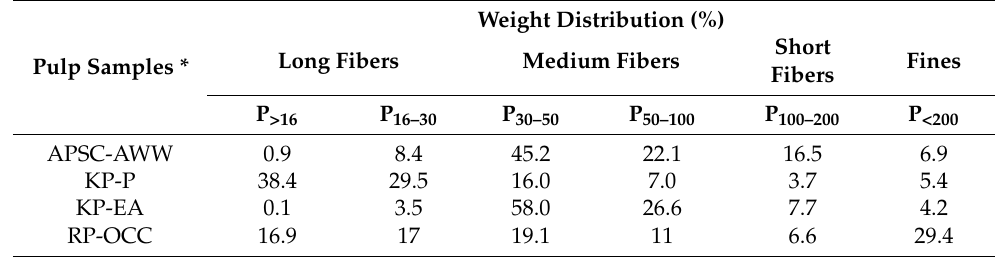
Table 1. Weight distribution of pulp fiber fractions retained on screens of 16, 30, 50, 100, 200 mesh (P >16 , P 16–30 , P 30–50 , P 50–100 , P 100–200 ) and passed through the screen of 200 mesh (P <200 ).